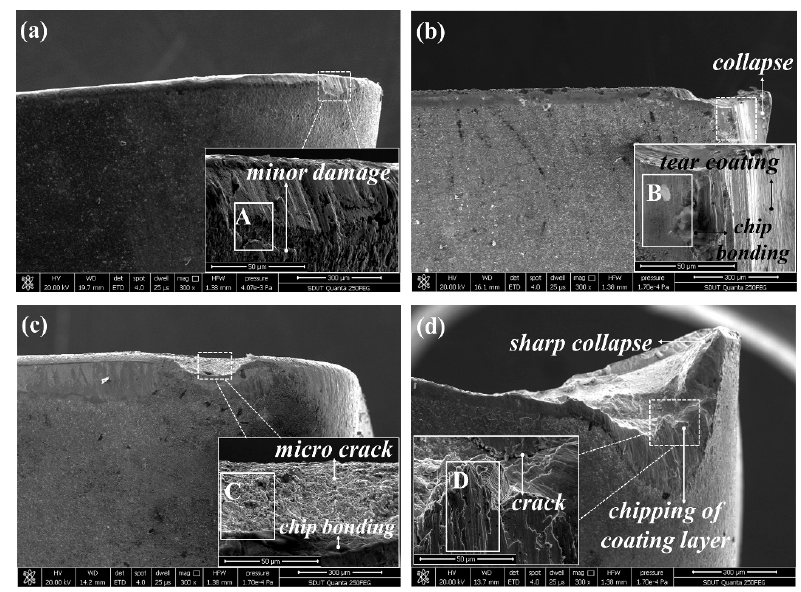
Figure 10. SEM micrograph of tool wear at v c = 440 m/min, f z = 0.04 mm, a p = 0.4 mm, and a e = 4 mm, ( a ) TiN/TiCN/TiAlN multi-coated tool, ( b ) AlTiN coated tool, ( c ) TiAlN + TiN coated tool, and ( d ) TiCN + NbC coated tool.